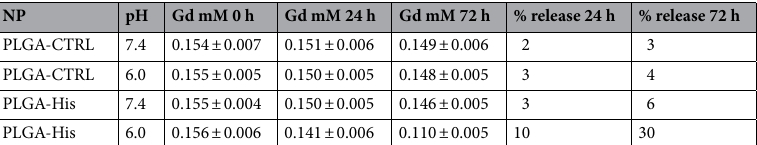
Table 3. NP stability and AT101 release at pH 7.4 and